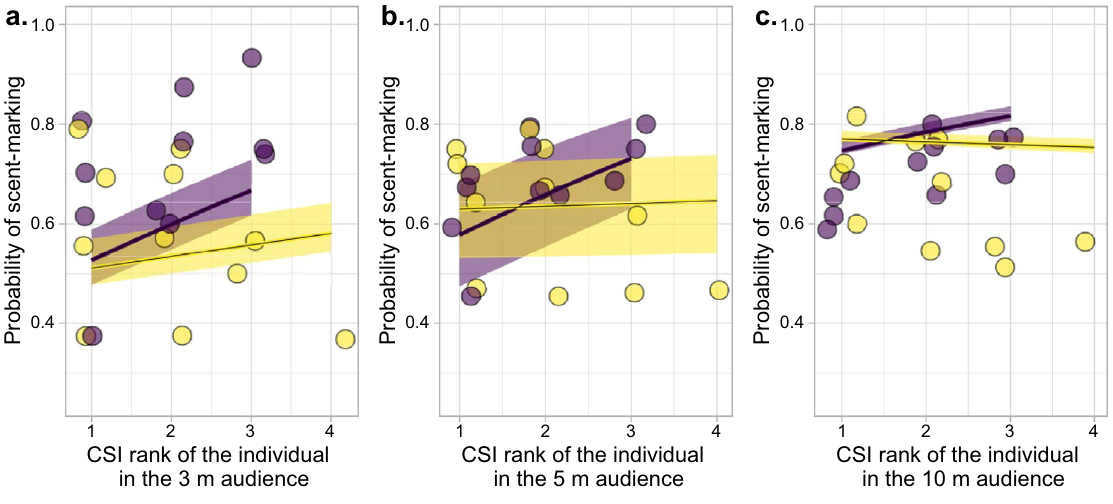
Figure 4. Probability to scent-mark as a function of the CSI rank of the individual in the audience when ( a ) in a 3 m radius, ( b ) in a 5 m radius, and ( c ) in a 10 m radius. The shaded areas show 95% confidence intervals of the model (conditional on the number of observations being at its average and on a group effect weighted by the number of individuals in each group). The first column of plots presents the zoomed-in section of the full range, indicated by grey polygons, to better depict the corresponding regression lines. This figure was visualized and edited using R (https:// www.r- proje ct.